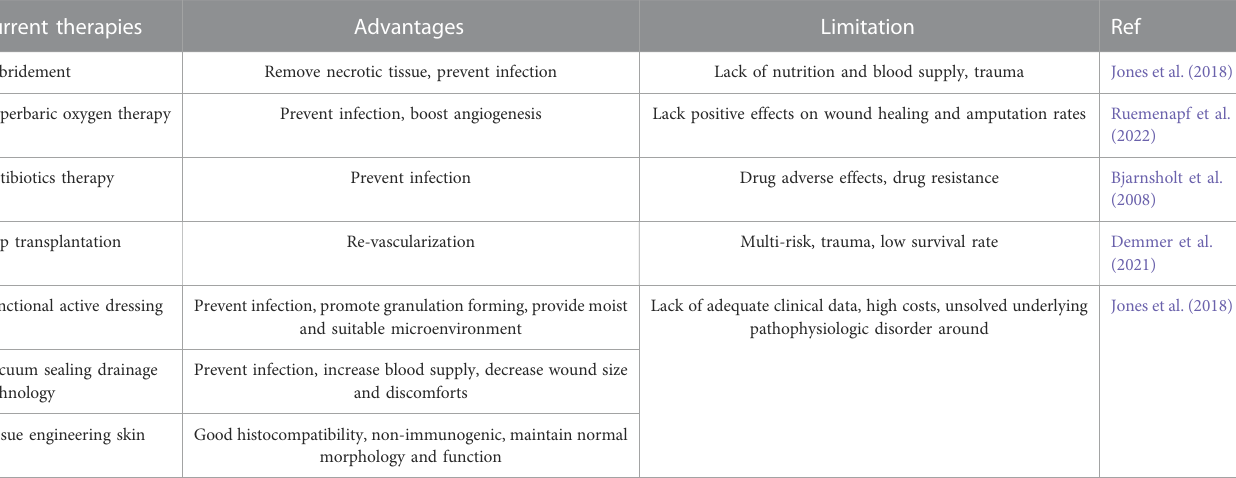
TABLE 1 Current chronic wound